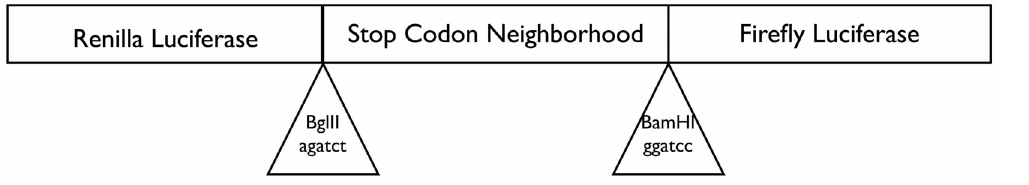
Figure 2. Plasmid Constructs. We inserted a neighborhood of the stop codon between the two luciferase reporter genes in the Dinman plasmid pJD375.